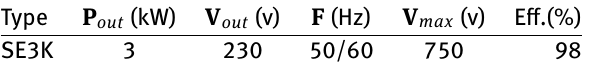
Table A13: DC/AC converter data and